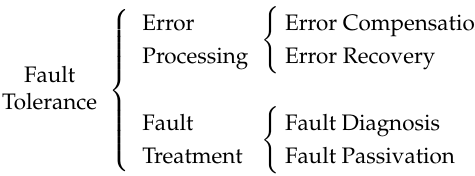
Figure 5. Definition of fault